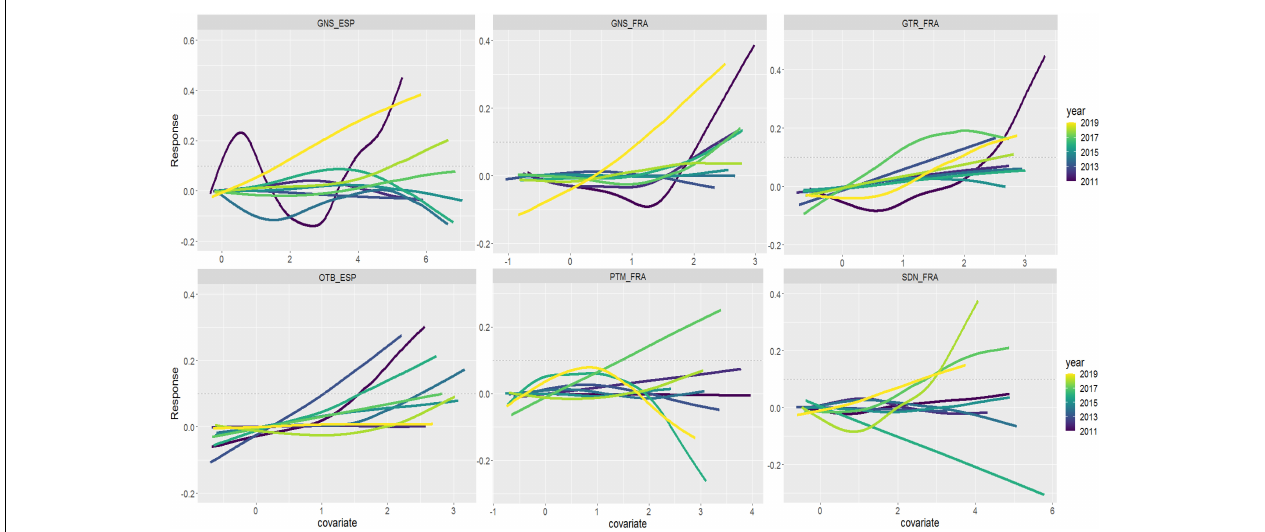
FIGURE 6 | Functional relationships between the origin of bycaught common dolphins and fishing effort in ICES subareas 27.8.a and 27.8.b for Spanish gillnetters (GNS_ESP), French trammel netters (GTR_FRA), French gillnetters (GNS_FRA), Spanish bottom trawlers (OTB_ESP), French midwater pair trawlers (PTM_FRA), French Danish seiners (SDN_FRA). Note that only fisheries which correlated positively at least twice since 2016 are presented. ICES - International Council for the Exploration of the